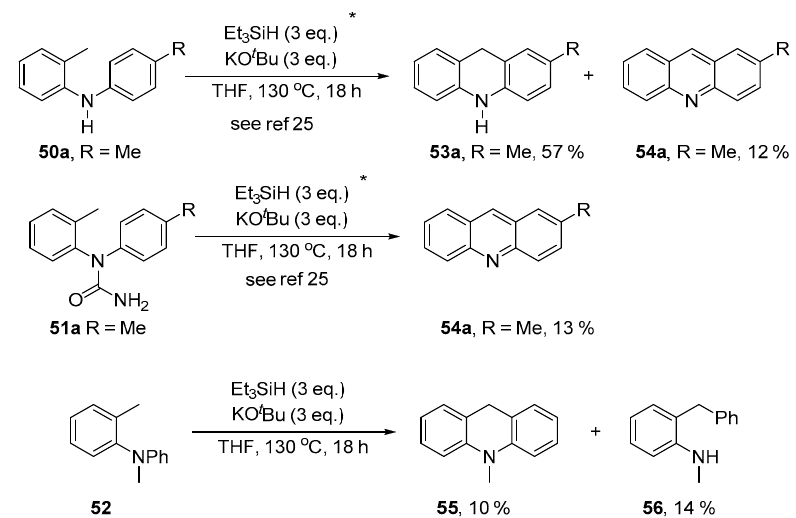
Scheme 9. Treatment of o -tolyl aryl amines with the Et 3 SiH/KO t Bu system.